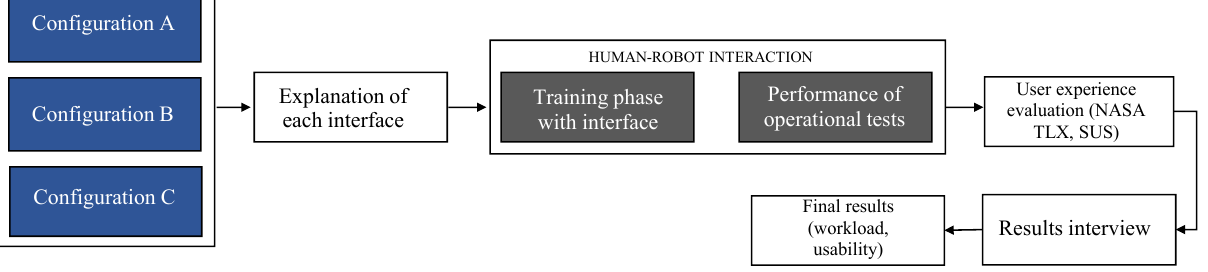
Figure 10. Block diagram of the analysis and evaluation